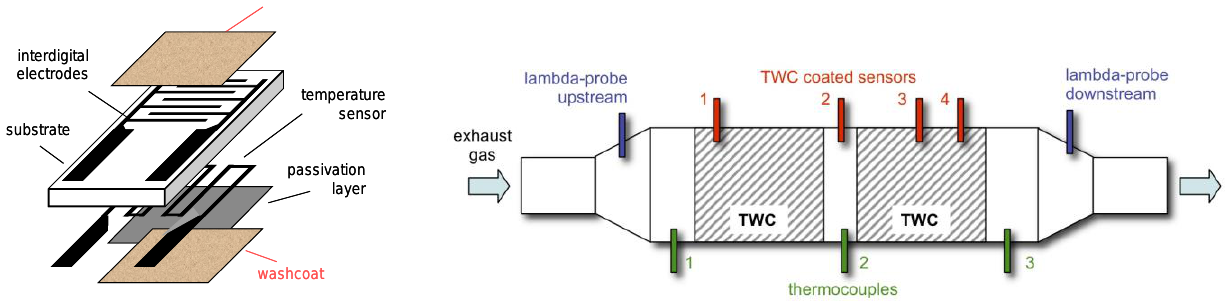
Figure 1. Schematic sensor element setup (left). Sensor positions in the catalyst (right). The numbers 1, 2, 3, and 4 denote the location of sensor elements. Results obtained from these sensors are shown in Figure 2. Modified after [17].